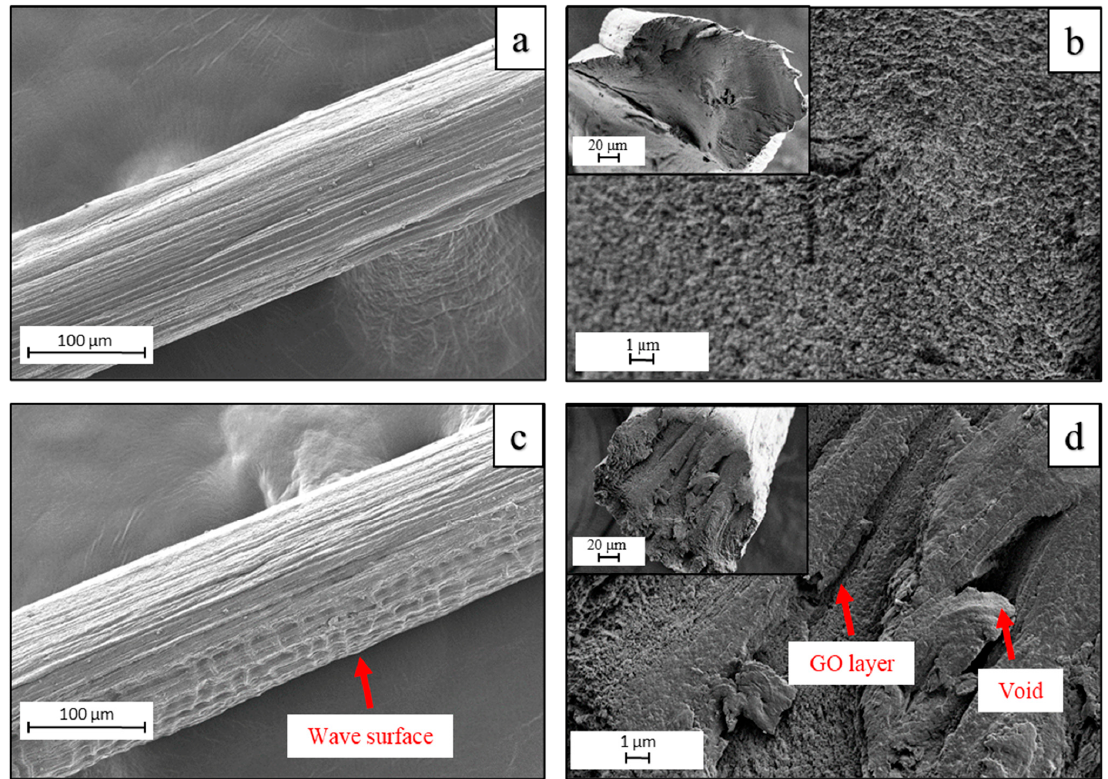
Figure 6. FESEM images of the surface of ( a ) RCF − 0 and ( c ) RCF − GO2. Cross-section (inset) and enlargement of ( b ) RCF − 0 and ( d ) RCF − GO2.